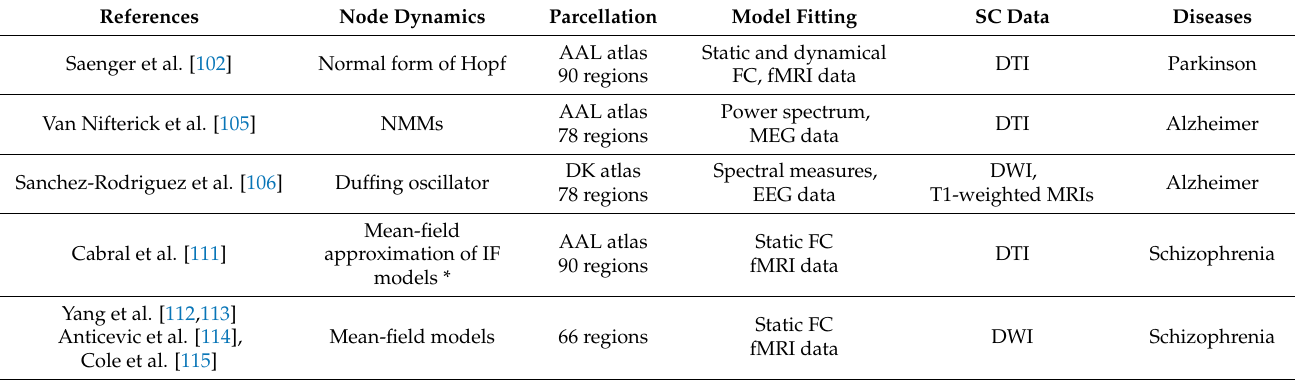
Table 2. Applications of multiscale BNMs in some brain